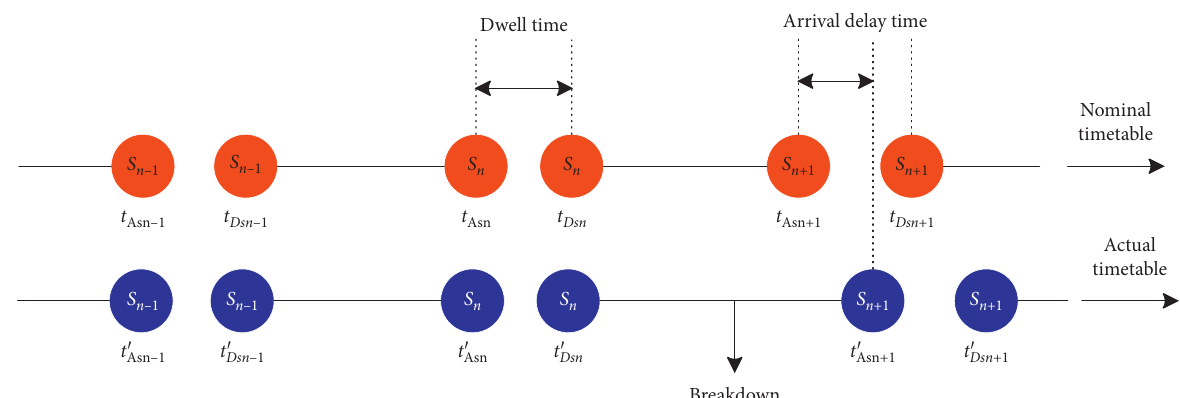
Figure 1: Conversion from the train itinerary to mathematical